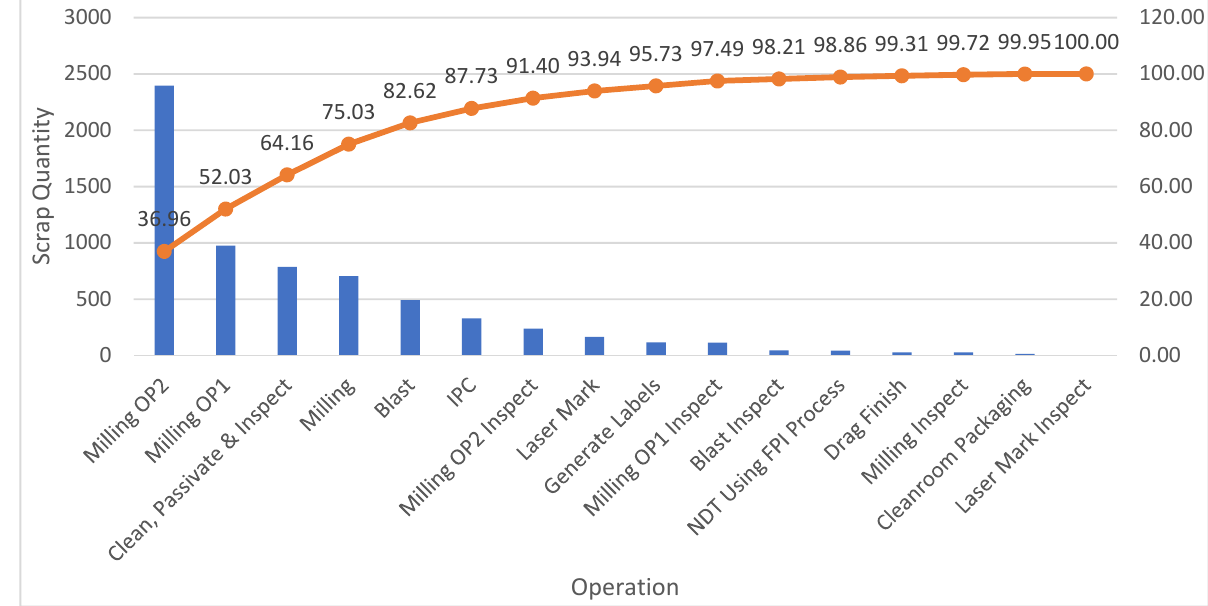
Figure 7. Pareto chart of operational scrap.